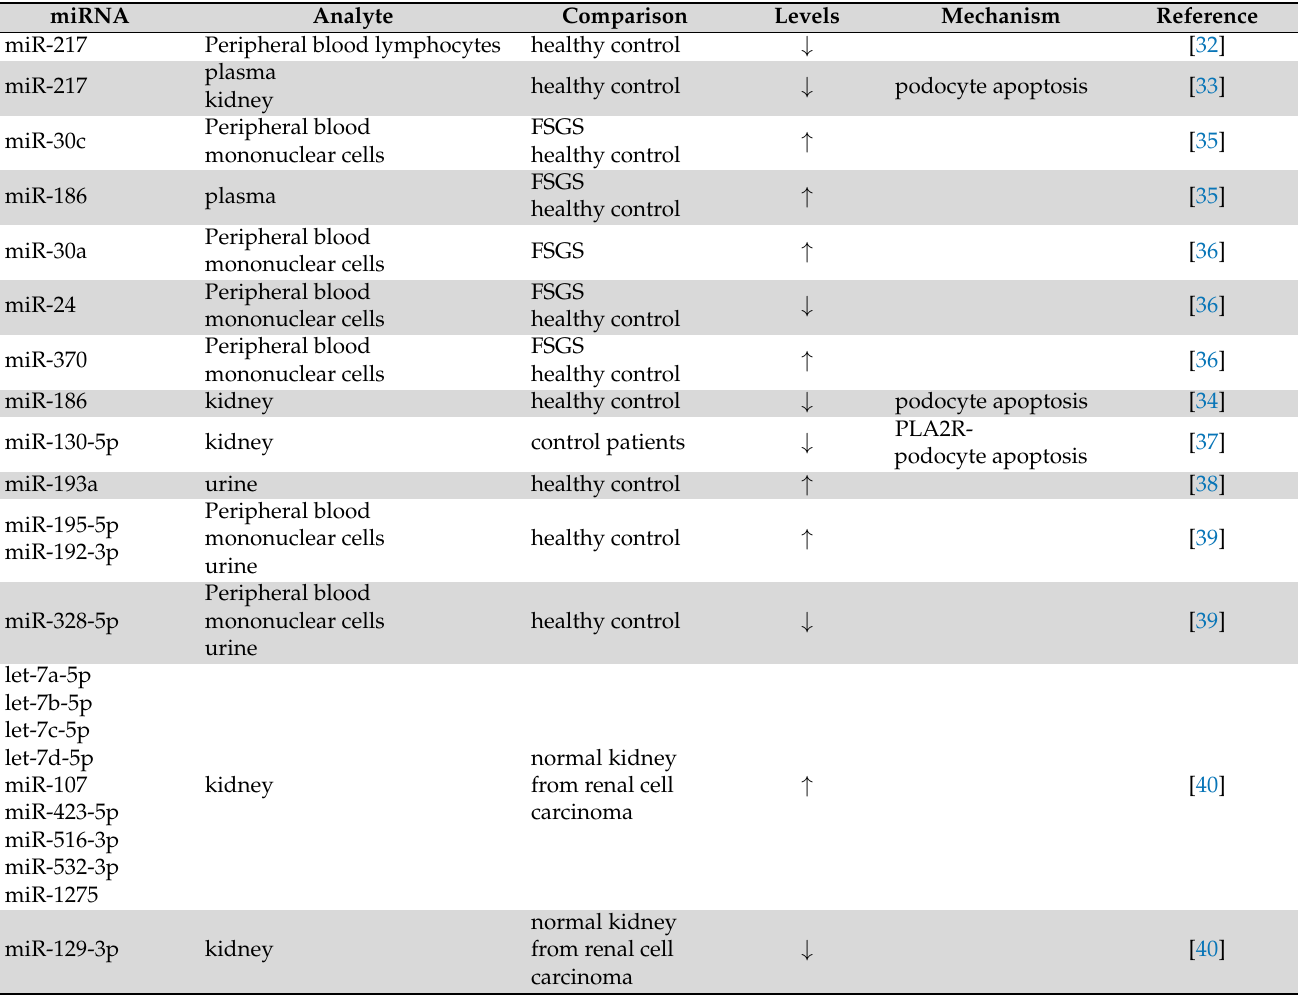
Table 2. MiRNAs in membranous